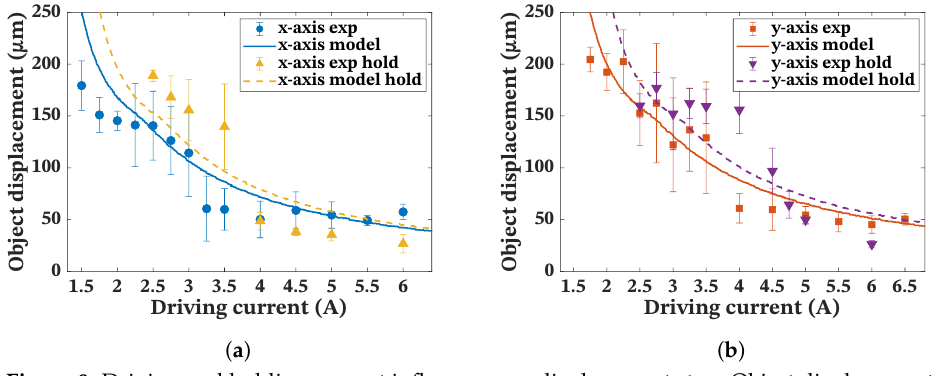
Figure 9. Driving and holding current influence on a displacement step: Object displacement vs. a varying driving current with and without a 1A holding current. ( a ) x -axis step. ( b ) y -axis